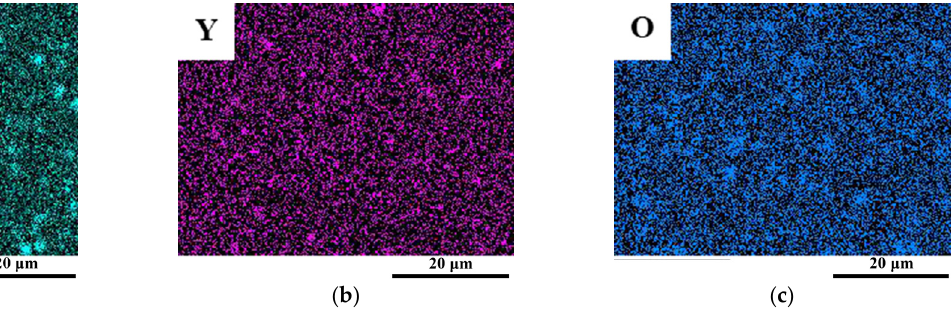
Figure 6. Distribution of ( a ) Si, ( b ) Y and ( c ) O elements in 1280-S3 ODS steels.